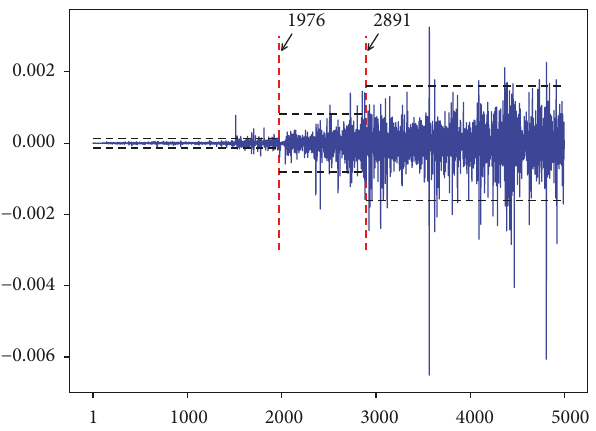
Figure7: Structuralchangestestresultsofminutereturnsofsimulated data . The CUSUM test finds 2 structural changes, namely, the 1976 time unit and the 2891 time unit marked by arrows in the figure, whichcandividetheentirereturnseriesinto3phases.Thefirstphase isfrom1to1976timeunit,thesecondphaseisfrom1977to2891time unit, and the third phase is from 2892 to the